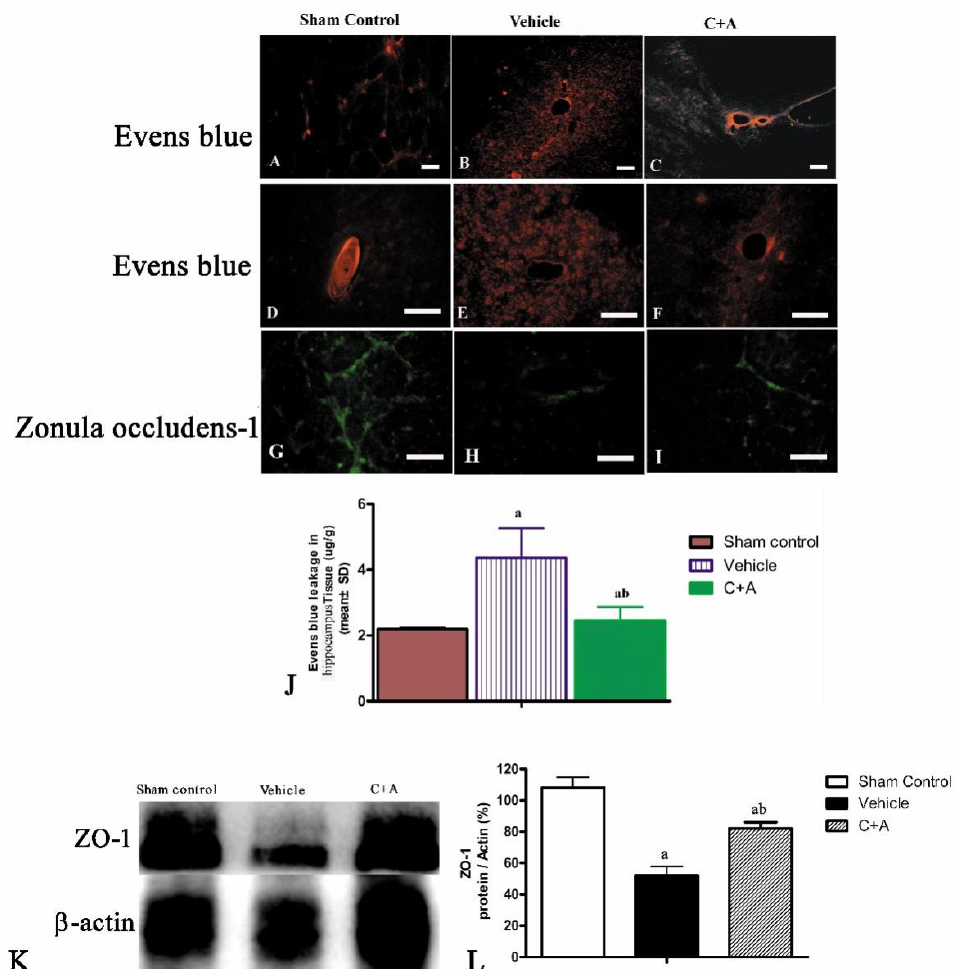
Figure 5. ( A – F ): Images of Evans blue (a dye to detect blood vessel leakage) staining (red) of the blood–brain barrier (BBB) in the ( A , D ) sham control, ( B , E ) vehicle, and ( C , F ) C + A groups. Increased blood vessel leakage in the vehicle group, as indicated by the amount of Evans blue dye that leaked out into surrounding blood vessels, was alleviated by the C + A treatment. ( G – I ): Immunofluorescence staining images (green) showed that ZO-1 (a marker of tight junctions) in micro-blood vessels was downregulated in the vehicle group, but was restored by C16 + Ang-1 treatment. Scale bar = 100 µ m. ( J ) Semi-quantitative profiles of Evans blue staining. ( K ) Western blot analysis of the expression of ZO-1. ( L ) Semi-quantitative profiles of protein bands showed that C16 plus Ang-1 increased the expression of ZO-1 in the vehicle group. ZO-1, 240 KD; β -actin, 42 KD. a, p < 0.05 vs. sham control group; b, p < 0.05 vs. vehicle group. a, p < 0.05 vs. sham control group; b, p < 0.05 vs. vehicle group.